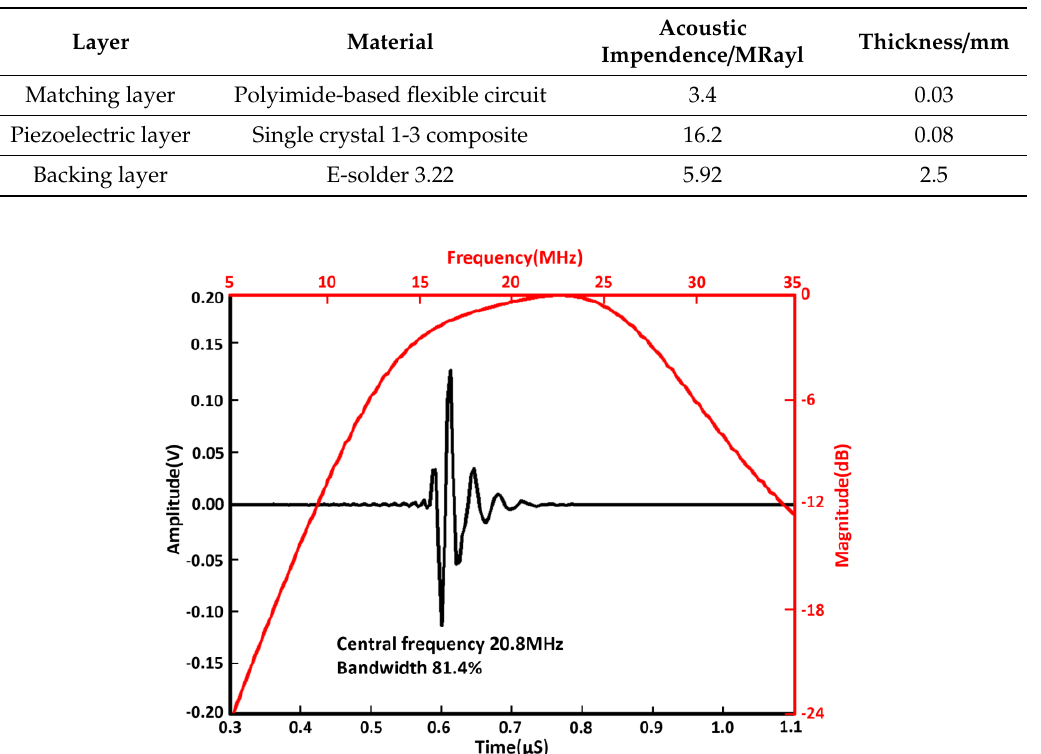
Figure 3. The simulated pulse-echo waveform and frequency spectrum of the transducer using the